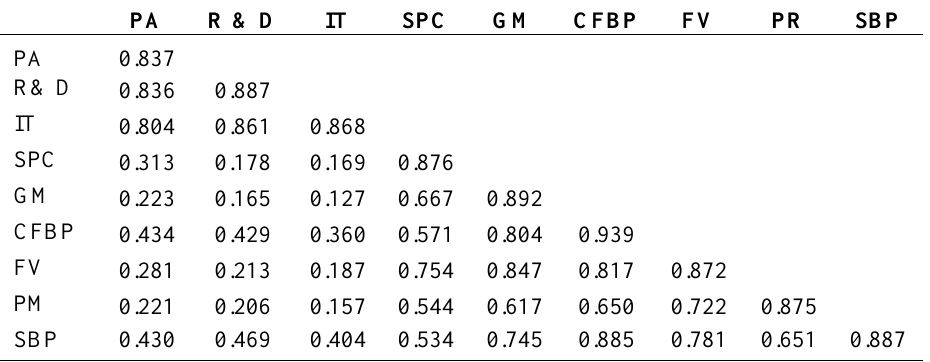
Table 2: Discriminant Validity of First-Order Constructs